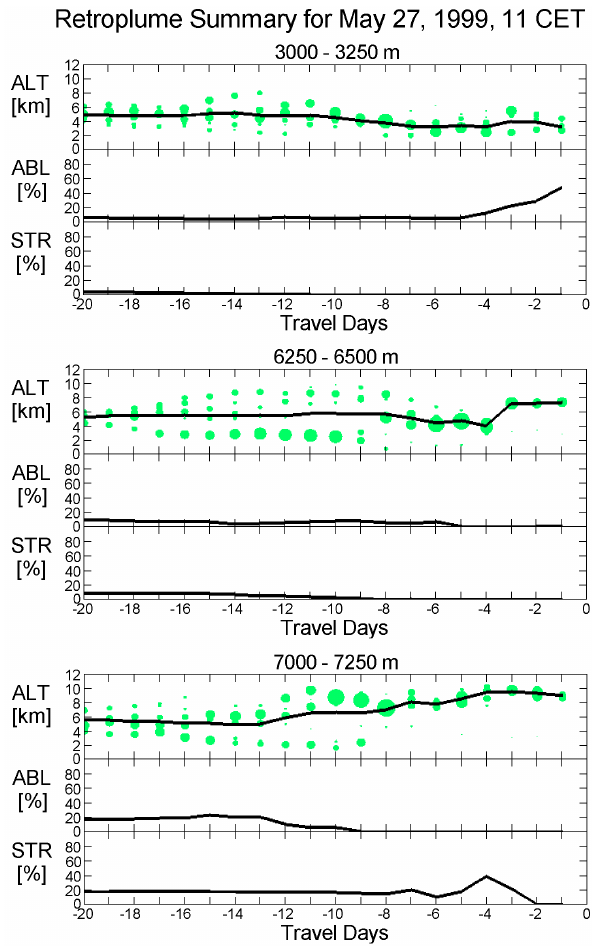
Fig. 13. Ozone sounding series in July 2001 at the beginning of a high-pressure period;S marks a stratospheric air intrusion, SA air from the subtropical Atlantic, the layers marked with the labels 1, 2 and 3 are discussed in the text. The time scale is given with respect to 00:00CET on 21